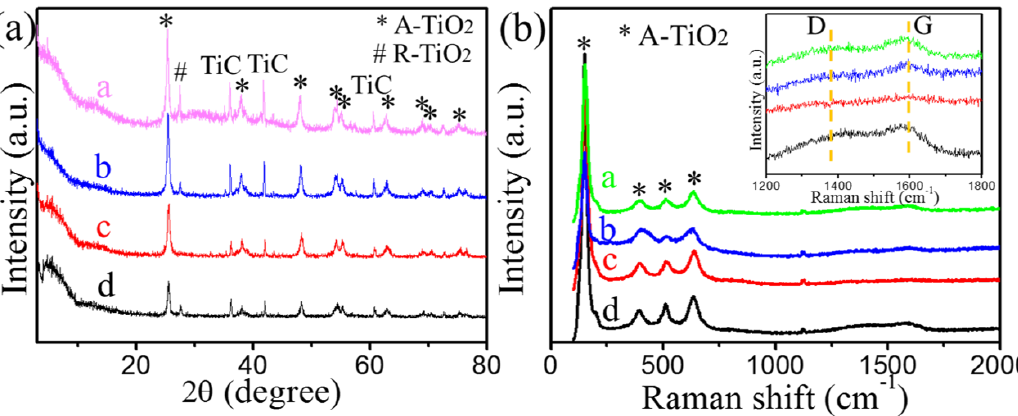
Figure 4. ( a ) XRD patterns and ( b ) Raman spectra of Ti 2 CT x after catalytic thermal decomposition of AP. a, b, c, d stand for Ti 2 CT x after catalytic thermal decomposition of AP in AP- x wt.%Ti 2 CT x ( x = 5, 10, 20, 30 wt.%) samples, respectively. The signs “*” and “#” stand for anatase and rutile, respectively. D and G stand for D-band and G-band of carbon, respectively.